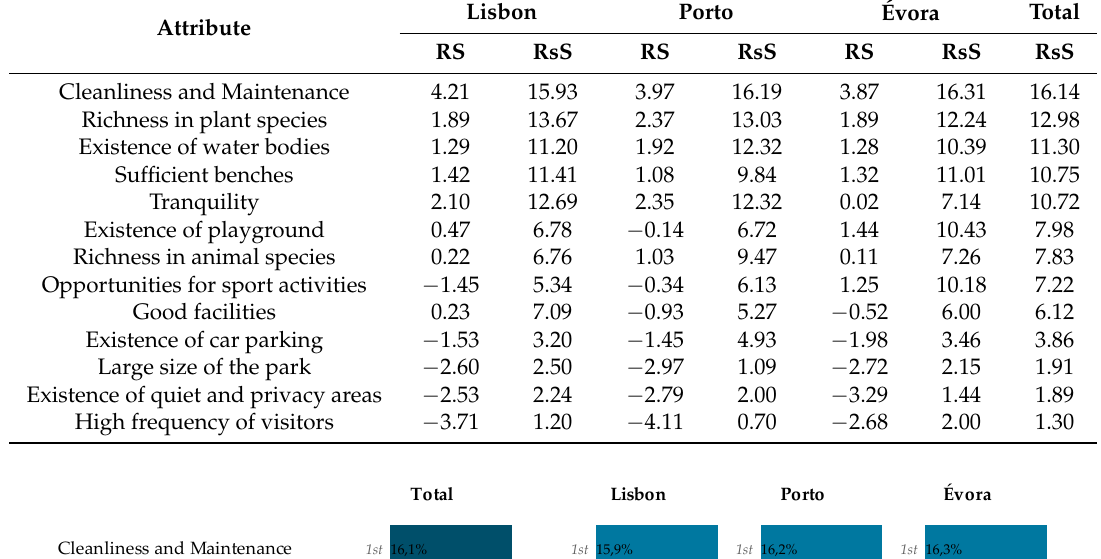
Table 3. Raw Scores (RS) and Rescaled scores (RsS) relating to the thirteen attributes.